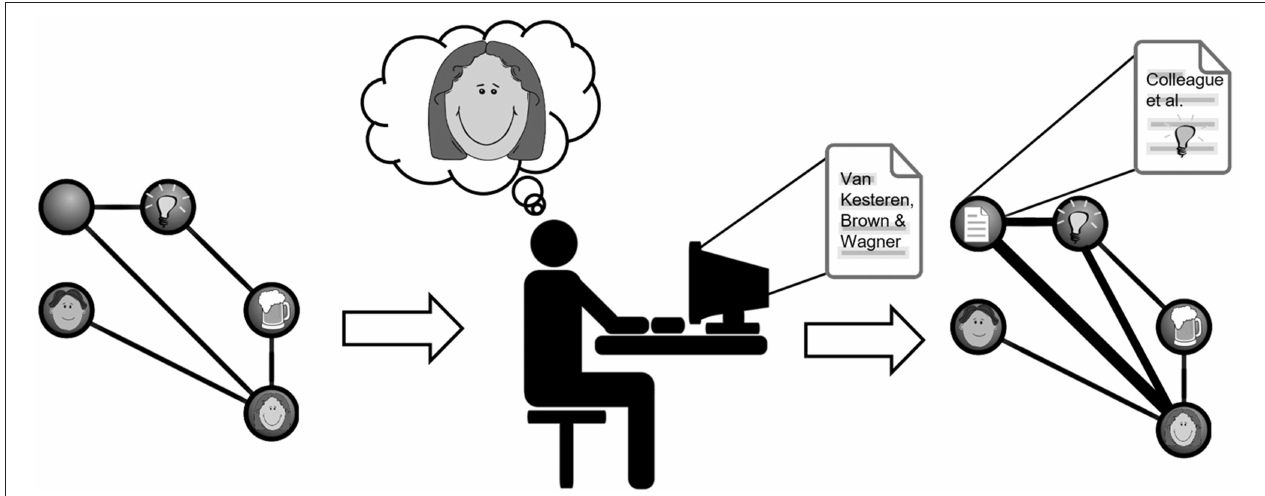
FIGURE 1 | Illustration of the potential generalizing and misattribution processes following reinstatement of prior knowledge during new learning. Imagine you have a strong memory engram of a colleague and good friend of yours, which includes memories about her husband and discussing research ideas about reinstatement and memory over a beer. Then you read our current paper which makes you reinstate the memory of your colleague and her ideas. This can lead to a change in this existing engram, integrating the paper with it and generalizing its ideas to the ones you discussed in the pub. While this process may strengthen existing connections in the engram (depicted as thickening lines in the right engram representation), it can also increase the possibility of misattributing the author to be your colleague (depicted in the representation of the paper).